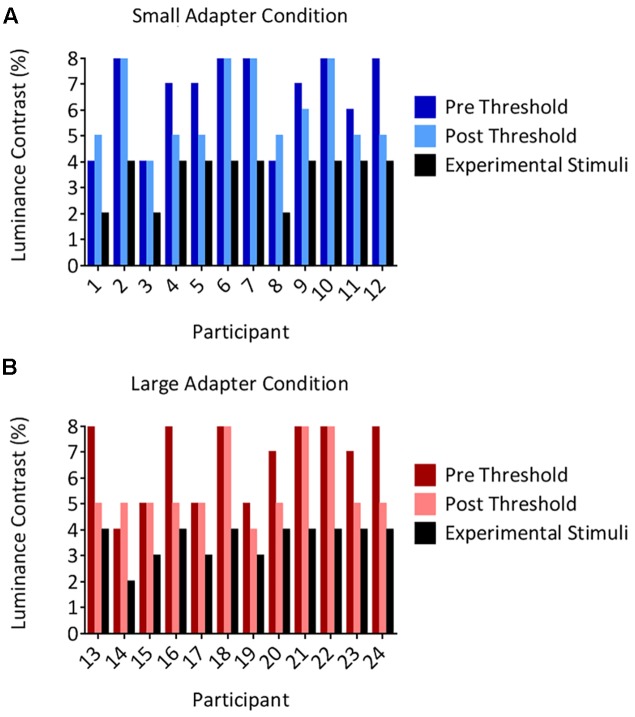
Individual suppression thresholds. The figure shows thresholds measured before (the pre condition in dark color columns) and after (the post condition in light color columns) the size aftereffects experiment, for both the small
(A) and large
(B)
adapter conditions. The x-axes represent the participant number and the y-axes represent the luminance contrast (%). Thresholds were defined as the lowest luminance contrast for which a stimulus broke suppression on any trial. Black columns denote the luminance contrast used to present the adapter in the size aftereffects experiment. Importantly, these values remained below the post threshold measurements in every participant. Thus, participants should not have ever been aware of the presence of the adapter stimulus in the size aftereffects experiment. This was subsequently confirmed by every participant reporting not having seen an adapter break suppression in the CFS condition in the size aftereffects experiment.